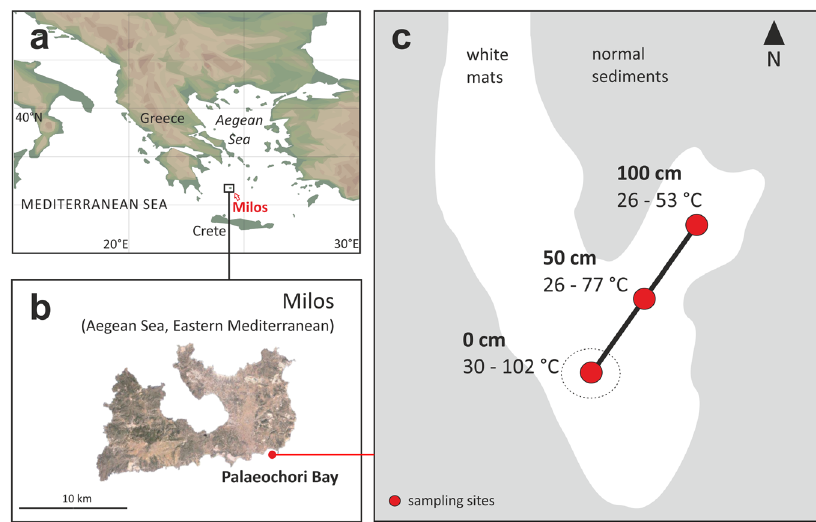
Fig. 1 Map and sketch of the study area. a Location of the island Milos (Greece). b Location of Paliochori Bay on Milos. c Sketch of the study area in Paliochori Bay showing the transect with temperature ranges for each sampling location (0, 50, and 100 cm) from the sediment surface to 9 cm sediment depth. The vent is located at a water depth of 10 m. The map in panel ( a ) was created using Ocean Data View (R. Schlitzer, https://odv.awi.de). The satellite image in panel ( b ) was taken from Google Earth (Google Earth data: SIO, NOAA, U.S. Navy, NGA, GEBCO, CNES/Airbus, Maxar Technologies). The sketch in panel ( c ) was created based on Yücel et al., 2013 11